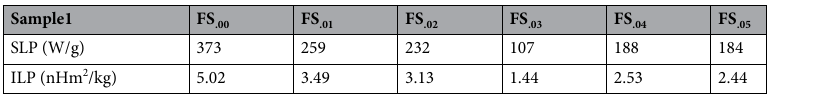
Table 3. Specific loss power (SLP) and intrinsic loss power (ILP) of the aqueous ferrofluids.